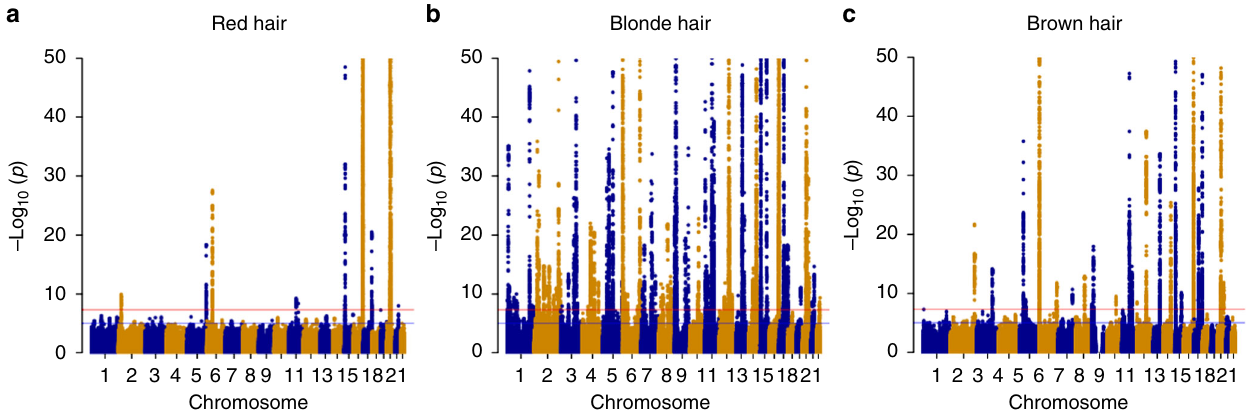
Fig. 1 Manhattan plots of GWAS data. Data plotted for a red hair vs. black plus brown hair, b blonde hair vs. black plus brown hair, c brown hair vs. black hair. Points are truncated at – log10( p ) = 50